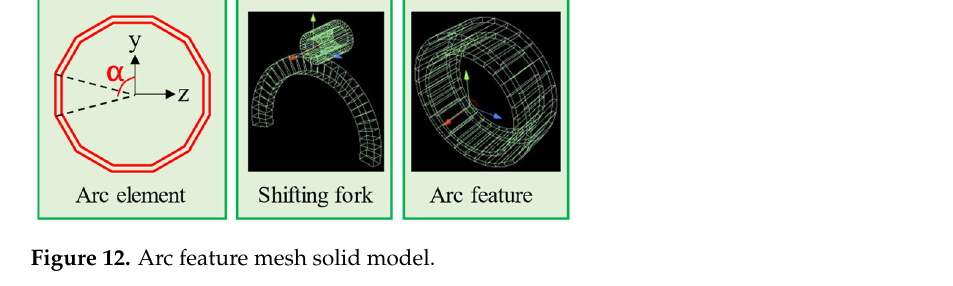
R is the inner diameter.